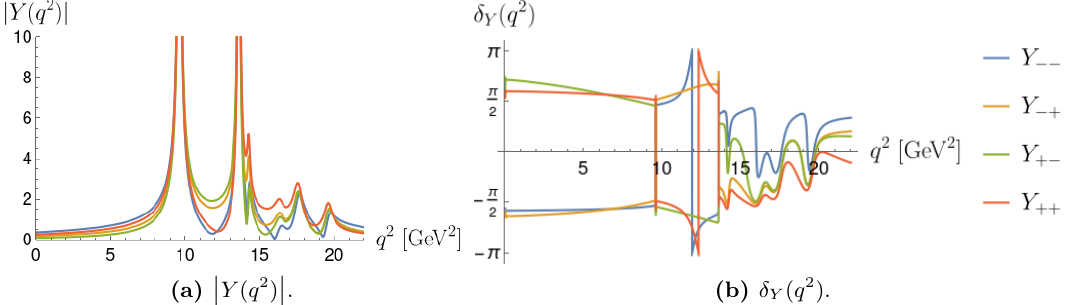
Figure 2 . Absolute value and phase of the hadronic long-distance function Y ( q 2 ) . The four colours show the four branches from [35] (see